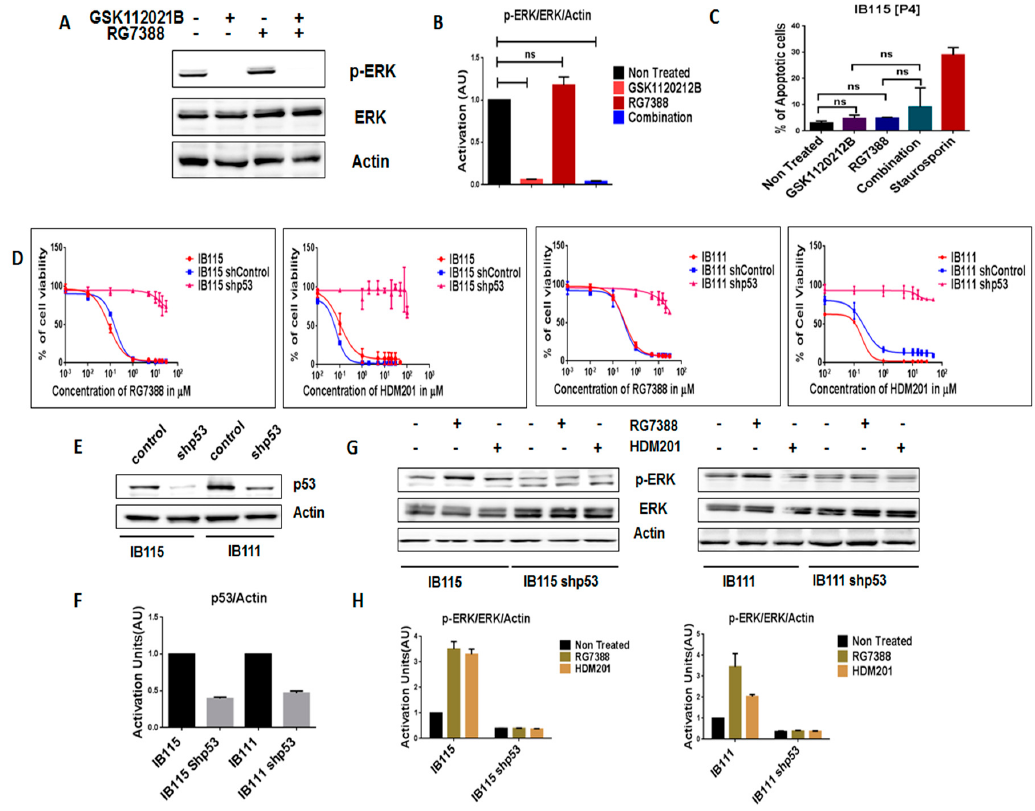
Figure 3. Intact functional p53 is necessary for MDM2 antagonists to activate MEK/ERK signaling in dedifferentiated liposarcoma. ( A ) Representative blots of IB115 [P4] treated with GSK112021B and RG7388, alone or in combination, at the EC 50 values for IB115 and immunoblotted for p-ERK and ERK. ( B ) Quantification of blots of IB115 [P4] cells treated with GSK112021B and/or RG7388. ( C ) Effect of GSK112021B and RG7388, alone or in combination, at the EC 50 values for IB115 on apoptosis in IB115 [P4] cells. ( D ) E ffi cacy of RG7388 and HDM201 in p53 wild-type and silenced IB115 and IB111 cells treated with increasing doses for 72 h. ( E ) Representative blots of p53 wild-type and silenced IB115 and IB111 immunoblotted for p53 to confirm p53 silencing. ( F ) Quantification of blots of p53 wild-type and silenced IB115 and IB111 cells immunoblotted for p53. ( G ) Representative blots of p53 wild-type and silenced IB115 and IB111 treated with RG7388 and HDM201 and immunoblotted for p-ERK and ERK. ( H ) Quantification of blots of p53 wild-type and silenced IB115 and IB111 cells treated with RG7388 and HDM201 and immunoblotted for p-ERK and ERK. ns (non-significant). Data represent the results of two experiments. Immunoblot data represent the results of two independent experiments and apoptosis data represent the results of three independent